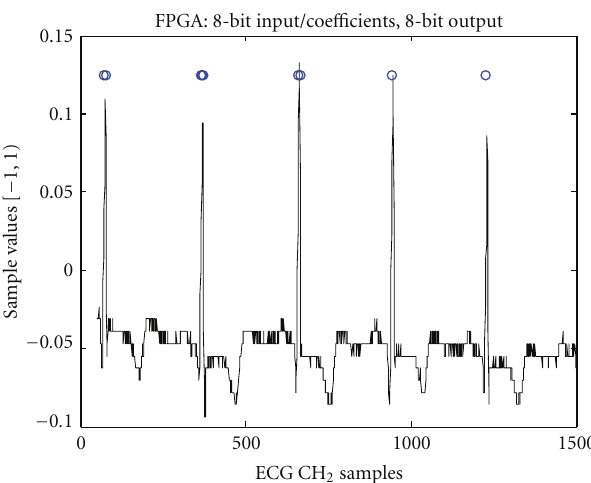
Figure 18: Perfect detection of R-waves for the first 5 ECG